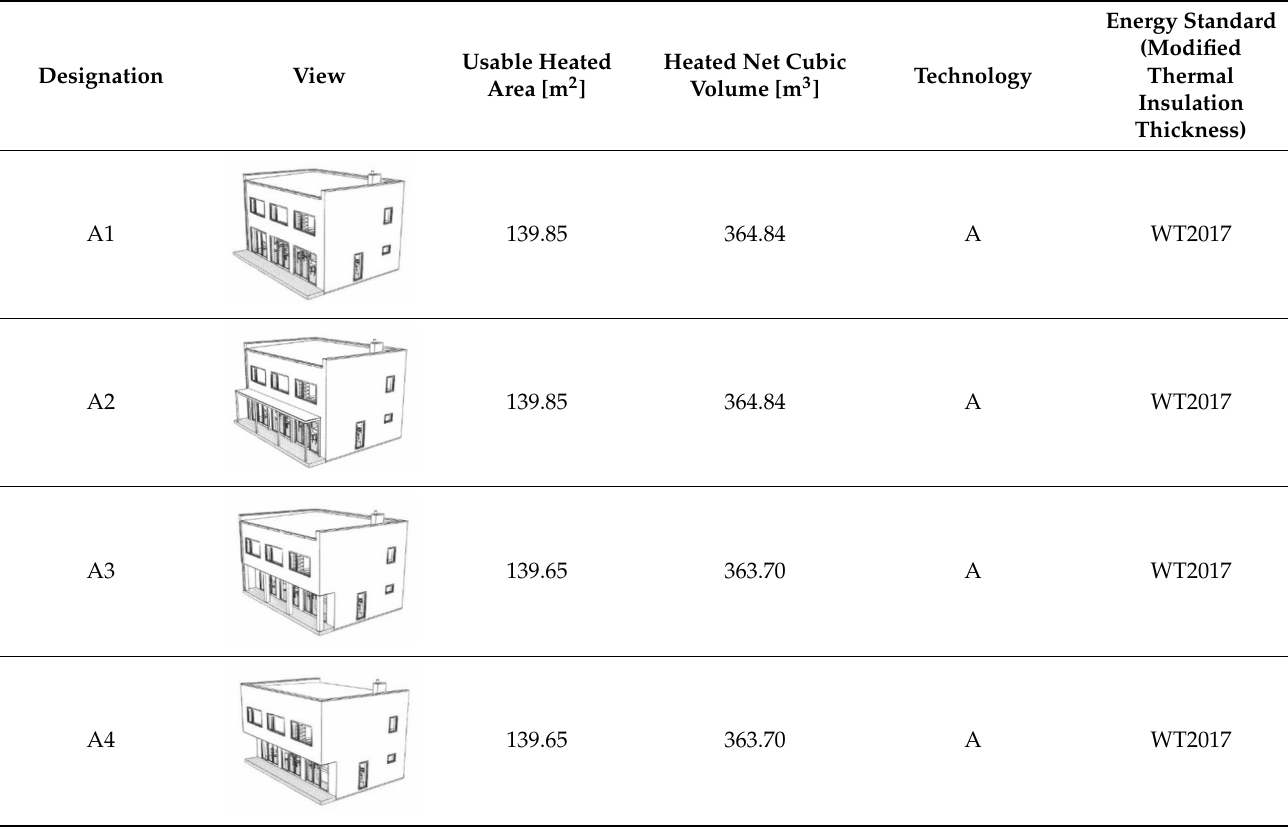
Table 5. Summary of analysed buildings. Designations of construction technologies: A—two-storey buildings with a flat roof (ventilated roof designed as a structure made of prefabricated hollow core plates supported on external walls and internal openwork walls). The buildings differ in the solution for permanent shading of large glazings on the south side of the ground floor. Model A1 lacks a window shading solution. Model A2 features a roof, while models A3 and A4 are shaded by overhanging a section of the second floor; B—two-storey buildings with a gable roof and a ventilated flat roof. The space between the ceiling above the top floor and the roof is a non-usable area. Model B1 lacks any window shading elements. The canopy designed in model B2 is the same as in model A2, with extended eaves to partially shade the windows on the second floor. The eaves were left in model A3, but without the awning. A roof with a slope of 45 ◦ was designed for model A4, so that the loft space could be used as an attic (non-heated area); C—two-storey buildings with a usable loft with a higher knee wall; elbow windows were used for this reason. Like model A1, model C1 does not have a canopy over the windows, while an awning identical to the one in model A2 was designed for model C2 to reduce overheating; D—two-storey buildings with a usable loft. As it was necessary to adapt the usable space to the previous variants, the building was designed to be wider (by 80 cm compared to the others) on the projection, and the arrangement of its functional layout was modified. As with the previous models, a building without any canopy (D1) was made, and two models were designed with an awning. Model A3 is a building with an additional dormer; E—one-storey buildings. Buildings with twice the building area were designed, but the applied solutions were the same as in the previous models. Model E1 is based on model A2; it has a similarly structured ventilated flat roof. Model E2 was designed with a gable roof in which the wide eaves provide sunlight protection; F—buildings adapted for disabled people in wheelchairs. Model F1 is based on model B2, while model F2 is based on model E1. The buildings were slightly enlarged compared to the original ones (models F1 and F2 by 5.26 m 2 and 0.61 m 2 , respectively) to meet the minimum requirements; PH—in contrast to the buildings in group A, this was